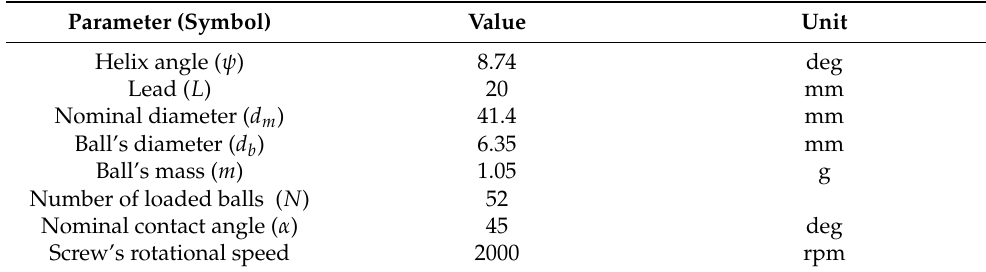
Table A1. List of the BSM